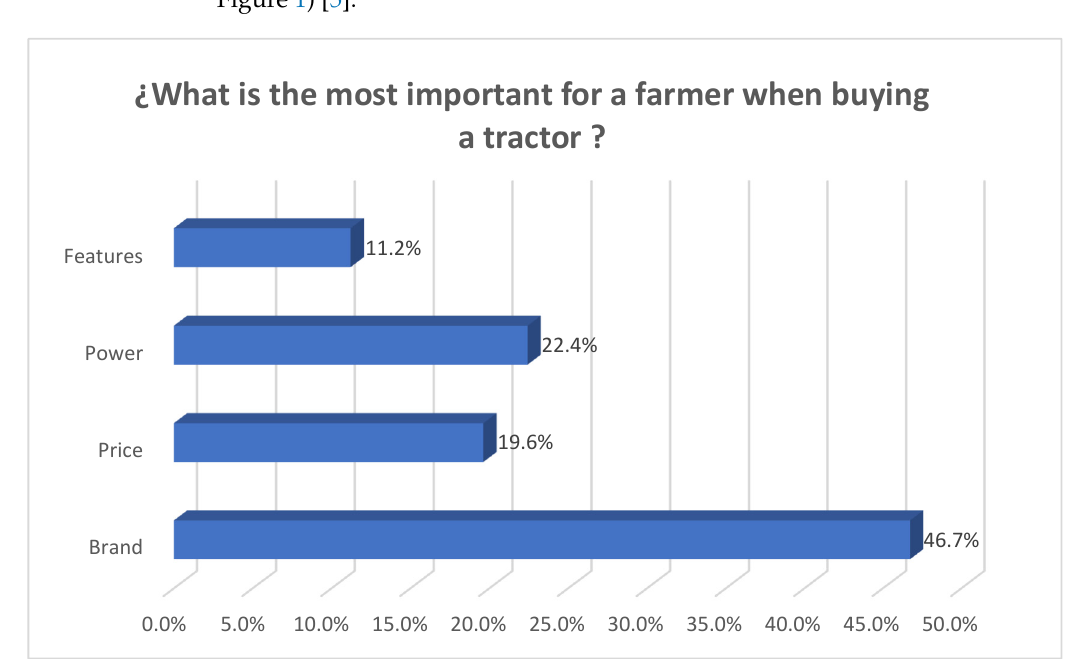
Figure 1. Most important factors for farmers when buying a tractor [5].